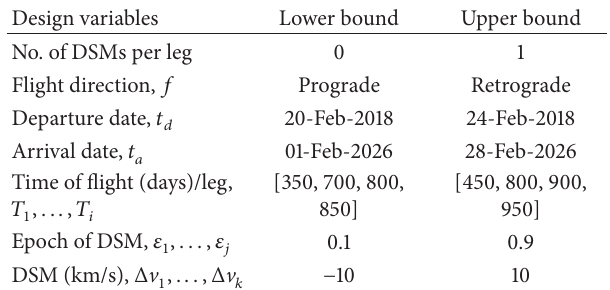
Table 7: Bounds on design variables for JEO mission: MGADSM